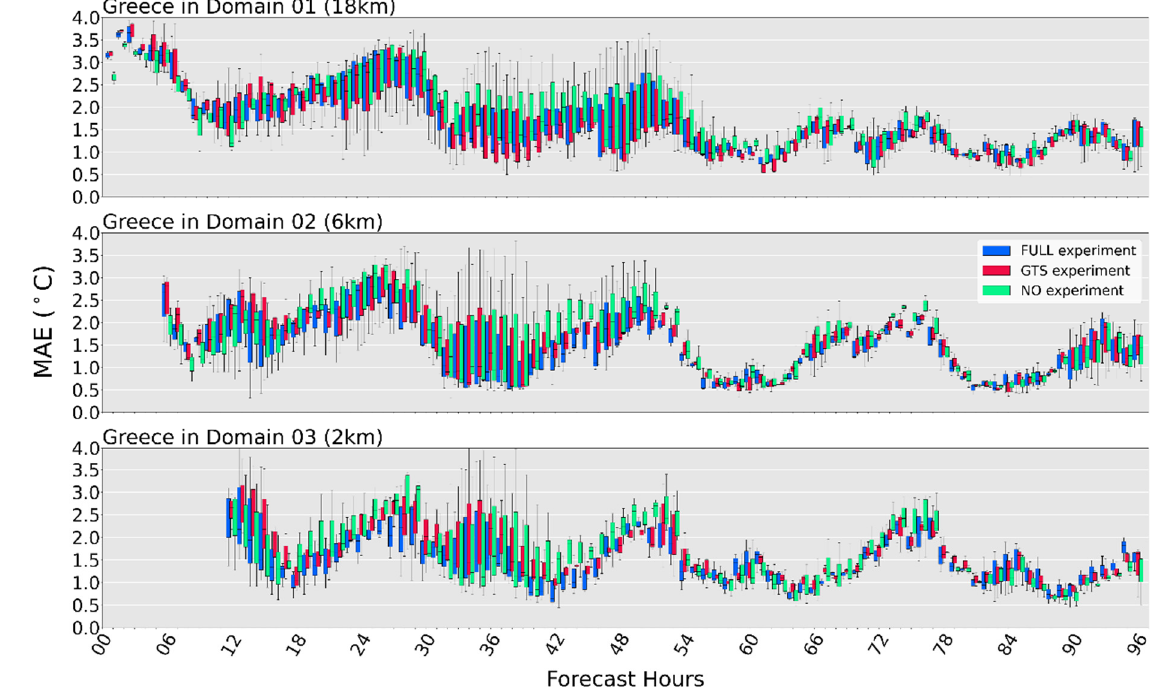
Figure 6. Hourly time series of 2 m temperature MAE for the area of Greece. Each panel refers to a specific spatial resolution domain and the scores achieved for each type of experiment (i.e., FULL, GTS, NO). In blue are the boxplots for the FULL experiment; the GTS experiment is depicted in red and the NO experiment is depicted in green.